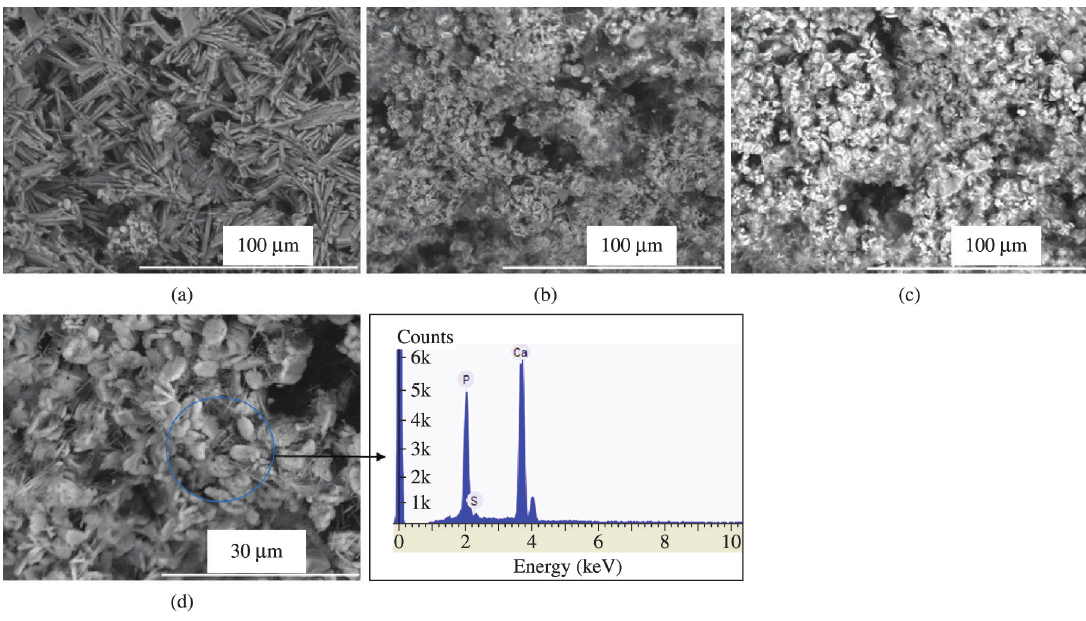
Figure 7. Micrographs regarding the fracture area of the blocks after different conversion times. Being: a) HAp_8h; b) HAp_24h; c) HAp_36h and d) Hap_36h with corresponding EDS